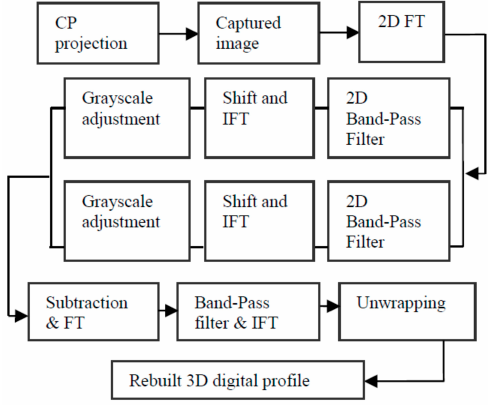
Figure 3. Block diagram of the system process.